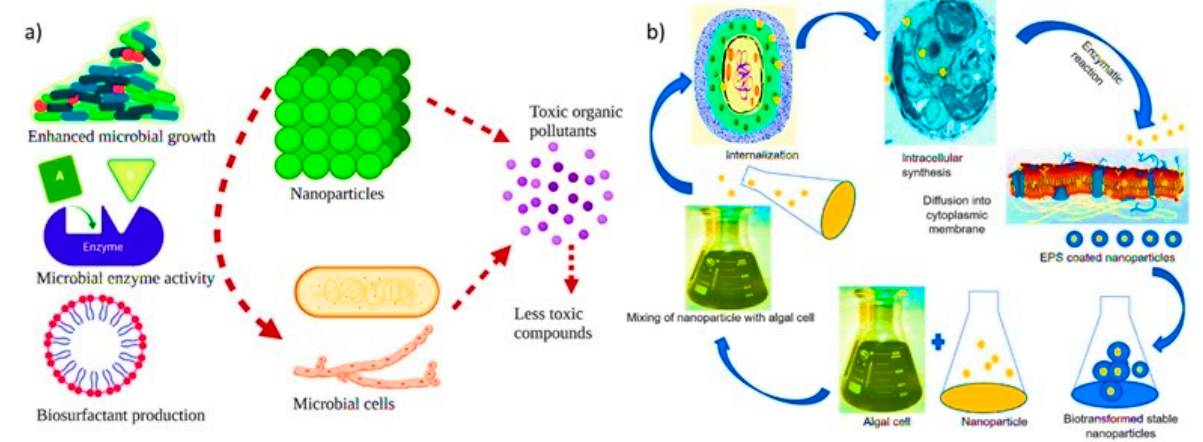
Figure 9. ( a ) Organic pollutant remediation using nanoparticles and microorganisms. Nanoparticles can be applied either directly or through adsorption to remove organic contaminants. Thereby facilitate bioremediation by enhancing the growth of microorganisms or by immobilizing contaminants through the production of microbial enzymes. ( b ) Exopolysaccharides-coated nanoparticle synthesis using algae [94]. Reprinted/adapted with permission from Ref. [94]. 2022, Elsevier B.V”.